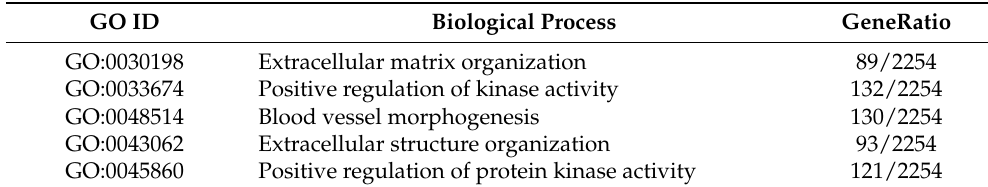
Table 10. Top 10 biological processes significantly (padj ≤ 0.01) enriched in genes differentially expressed in M2_B versus M2_C